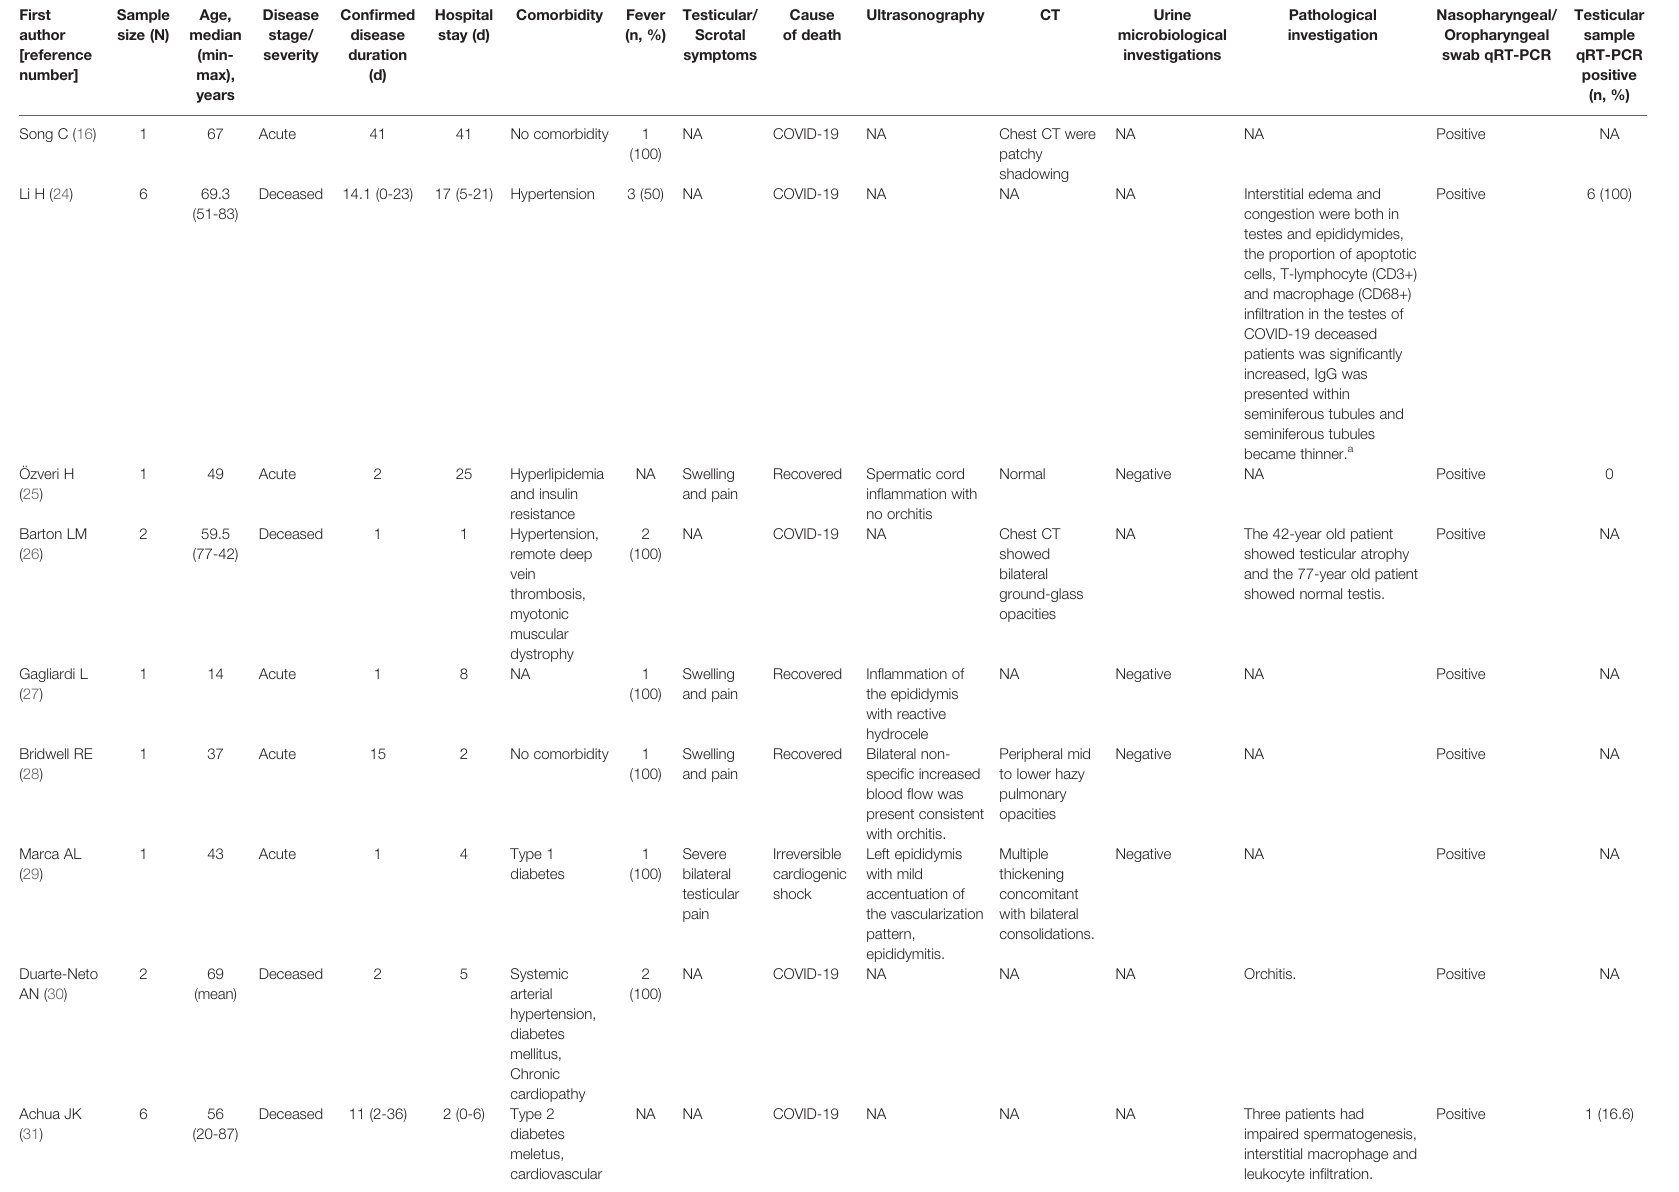
TABLE 3 | Descriptive Results in the Testes/Scrotum of Patients With COVID-19. First